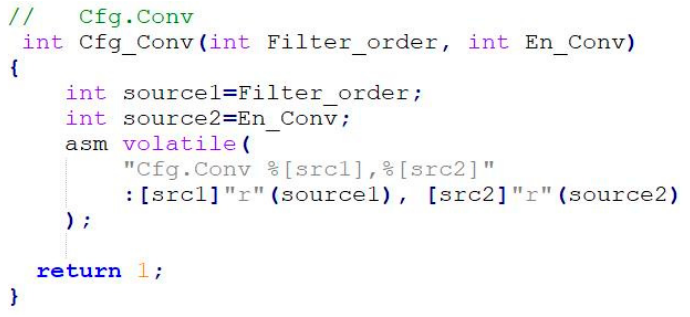
Figure 10. Library function of Cfg.Conv instruction.